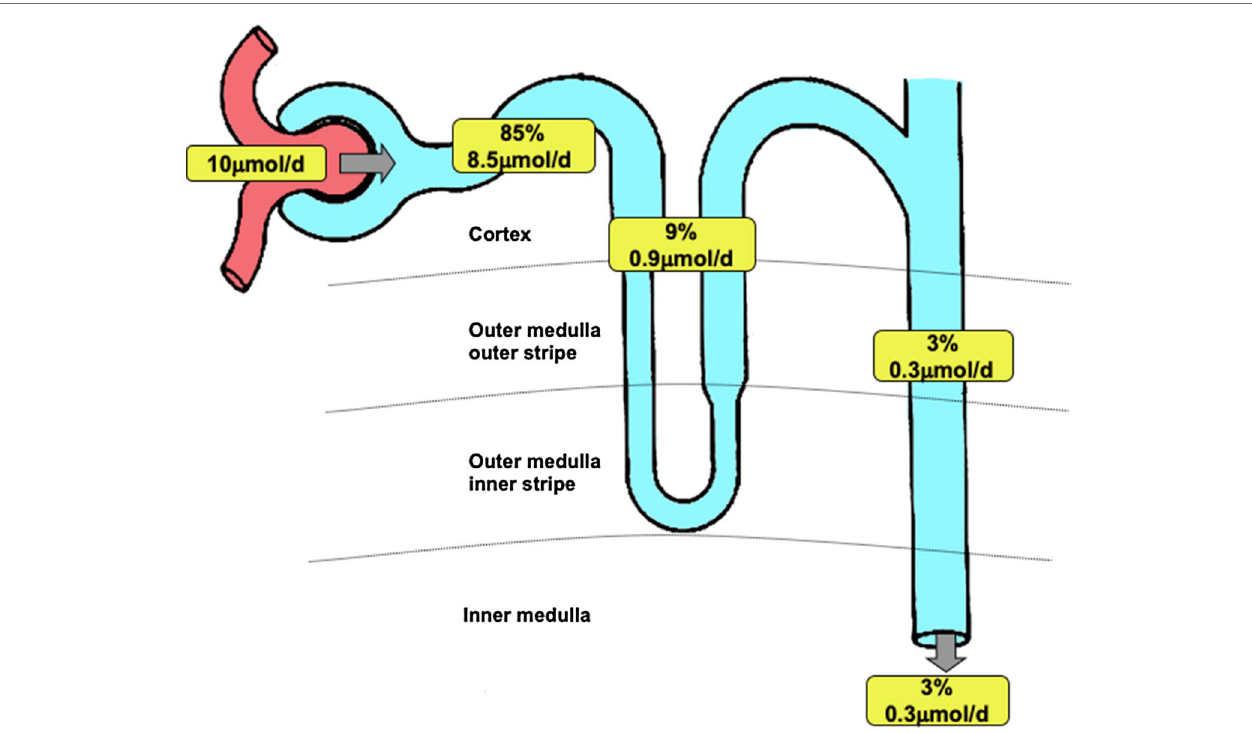
FIGURE 6 | Renal iron transport. Model of renal iron handling along the nephron showing estimated quantitative contribution of three groups of nephron segments. Percentage data refer to the amount of filtered iron reabsorbed. Values apply to a 250 g Wistar rat and are based on data presented in this manuscript and Wareing et al., 2000). Filtered load of iron was calculated assuming a glomerular filtration rate of 2.25 l.day − 1 (Bijsterbosch et al., 1981) and taking the 30 kDa ultrafiltrate iron concentration of 4.48 μ mol.l − 1 as representative of the concentration of iron filtered. Iron remaining at the end of the PCT was calculated assuming 60% of filtered water is reabsorbed along PCT and taking the end PCT iron concentration to be 1.8 μ mol.l − 1 (from Figure 1 ). PCT reabsorption of iron was calculated by subtracting end PCT iron concentration from the filtered load of iron. The amount of iron reabsorbed by the loop of Henle or DCT and collecting ducts was calculated using the urinary iron concentration as a starting point (value taken Wareing et al., 2000,) and assuming 20% of injected iron was reabsorbed downstream of the PCT (value taken Wareing et al., 2000). Iron present at the start of the DCT was calculated assuming 50% of injected iron was reabsorbed downstream of the DCT. Iron reabsorbed by loop of Henle was calculated by subtracting the calculated value for the DCT from the measured iron concentration at the end of the PCT (from Figure 1